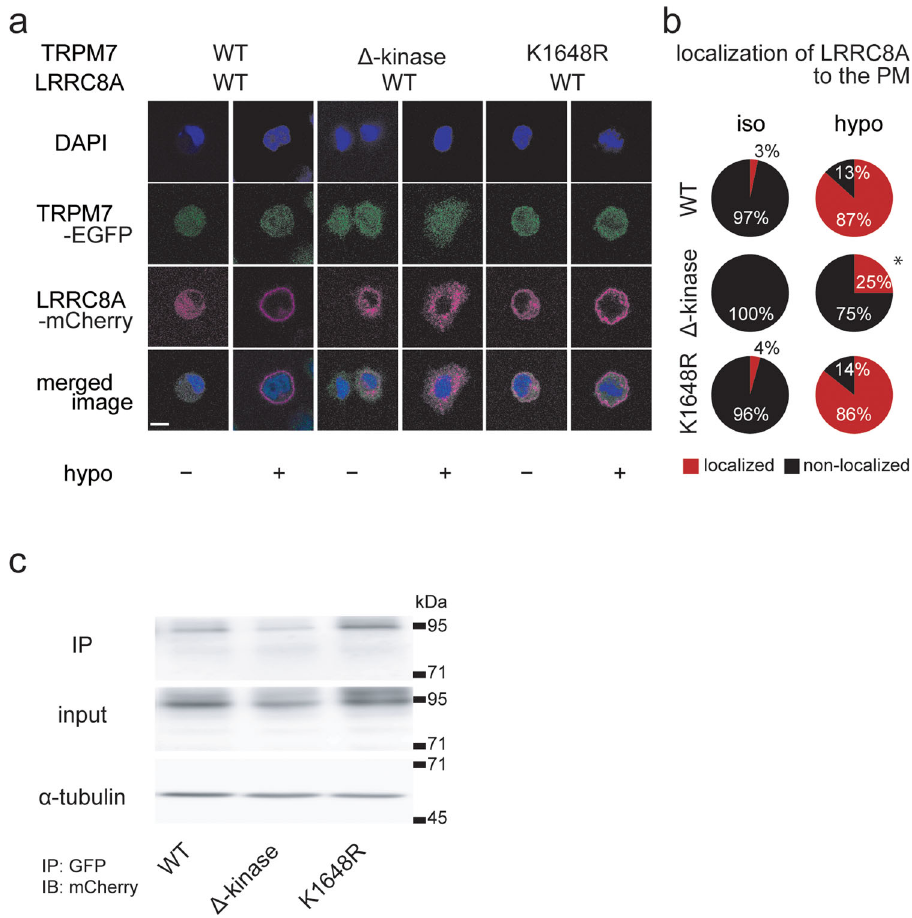
Fig. 9 Subcellular co-localization and molecular interactions of TRPM7-WT, - Δ -kinase, and -K1648R mutants with LRRC8A after exposure to hypotonic solution. a Confocal images of DAPI-stained HeLa cells before ( DAPI ) and after immunostaining with anti-GFP antibody for WT hTRPM7 or its mutant ( TRPM7-EGFP : green), and those with anti-mCherry antibody for LRRC8A ( LRRC8A-mCherry : red) during exposure to hypotonic solution (78% osmolarily). Scale bar, 5 μ m. b The percentage of LRRC8A localization to the plasma membrane ( PM ) is signi fi cantly lower for the TRPM7 C -terminal defect ( + Δ -kinase , hypo : * P ( = 0.00060) <0.001 compared to corresponding WT data by χ 2 test). Observations and analyses were performed from 14 to 121 individual cells. c Co-immunoprecipitation of hTRPM7-EGFP ( WT ), - Δ -kinase-EGFP, or -K1648R-EGFP with LRRC8A-mCherry in HEK293T cells co- transfected with hLRRC8A-mCherry and EGFP-tagged hTRPM7 or its mutant. Immunoprecipitations ( IP ) with a GFP-speci fi c antibody were subjected to western blot with an antibody to mCherry. For input, aliquots of sample are loaded on a separate gel. The data are representative of three independent mutant (Fig. 9a: merged image ). Then, a possible physical interaction of TRPM7 and LRRC8A was tested by co- immunoprecipitation of LRRC8A and TRPM7 extracted from osmotically swollen HEK293T cells co-transfected with LRRC8A- mChery and TRPM7-EGFP. As shown in Fig. 9c ( WT ; Supple- mentary Fig. 4b: WT ) and Supplementary Fig. 2b ( TRPM7-EGFP ), LRRC8A was found to be co-precipitated with WT TRPM7 ( IP ). In contrast, such co-precipitated bands ( IP ) were not detected when co-transfected with LRRC8A-mCherry and TRPM4-EGFP (Sup- plementary Fig. 2b: TRPM4-EGFP ). The K1648R mutant of hTRPM7 exhibited similar co-precipitation with LRRC8A ( IP: K1648R ), whereas co-precipitated bands were not much found with the Δ -kinase mutant ( IP: Δ -kinase ). These data strongly suggest that LRRC8A becomes localized at the plasma membrane and interacts with TRPM7 presumably via the C -terminal kinase domain of TRPM7 after osmotic cell swelling.